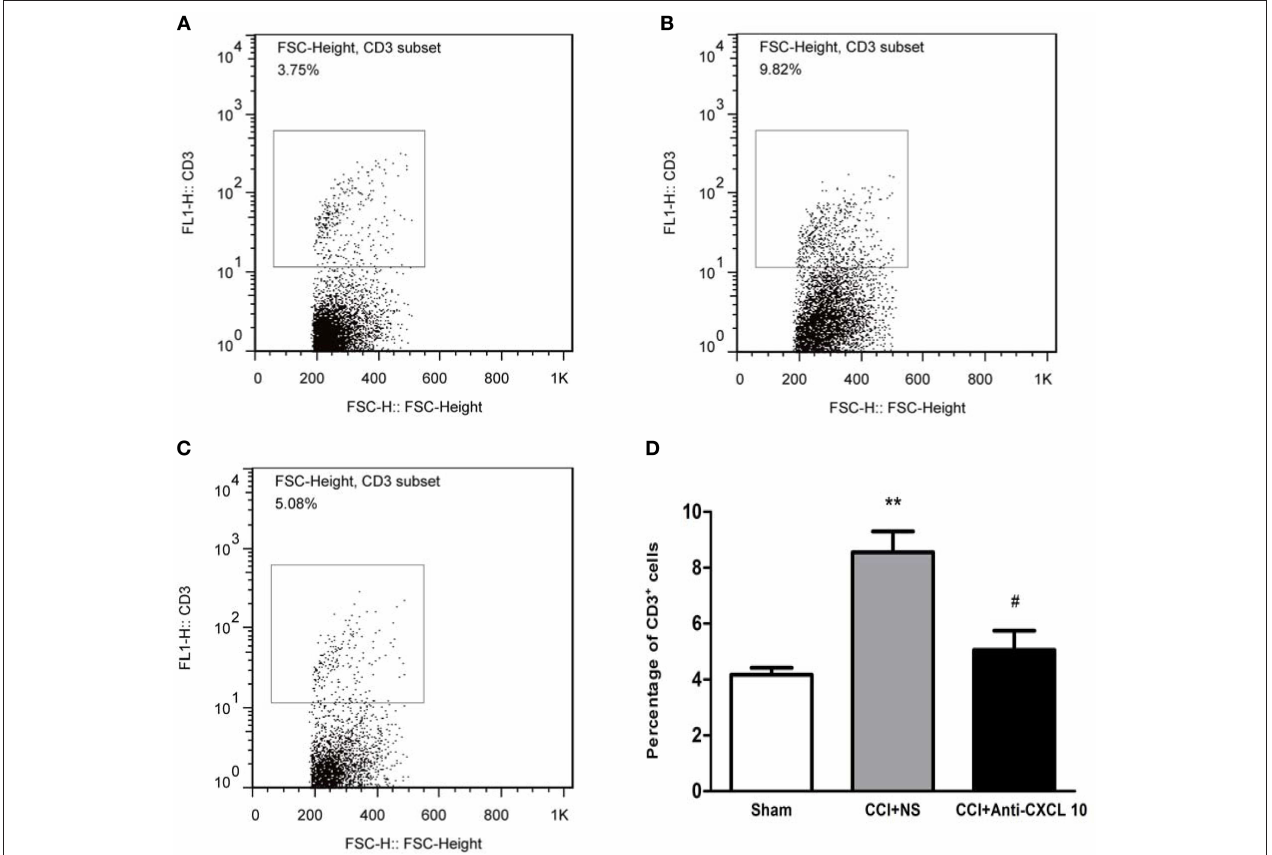
FIGURE 5 | Neutralizing CXCL10 reduced CCI-induced T cell infiltration of the dorsal horn. (A,B) CD3-positive T cell levels as percentages of CCI-ipsilateral dorsal horn mononuclear cell populations in the sham surgery group and CCI + NS group rats (** p < 0.01; independent t- test, n = 3–4). (B,C) CD3-positive T cell levels as percentages of CCI-ipsilateral dorsal horn mononuclear cell populations in CCI + NS group and CCI + anti-CXCL10 antibodies group rats ( # p < 0.05; independent t- test, n = 3). (D) Bar chart indicating the statistical analysis. The data are shown as means ± standard errors. CCI, chronic constriction injury; CXCL10, C-X-C motif chemokine 10; NS, normal